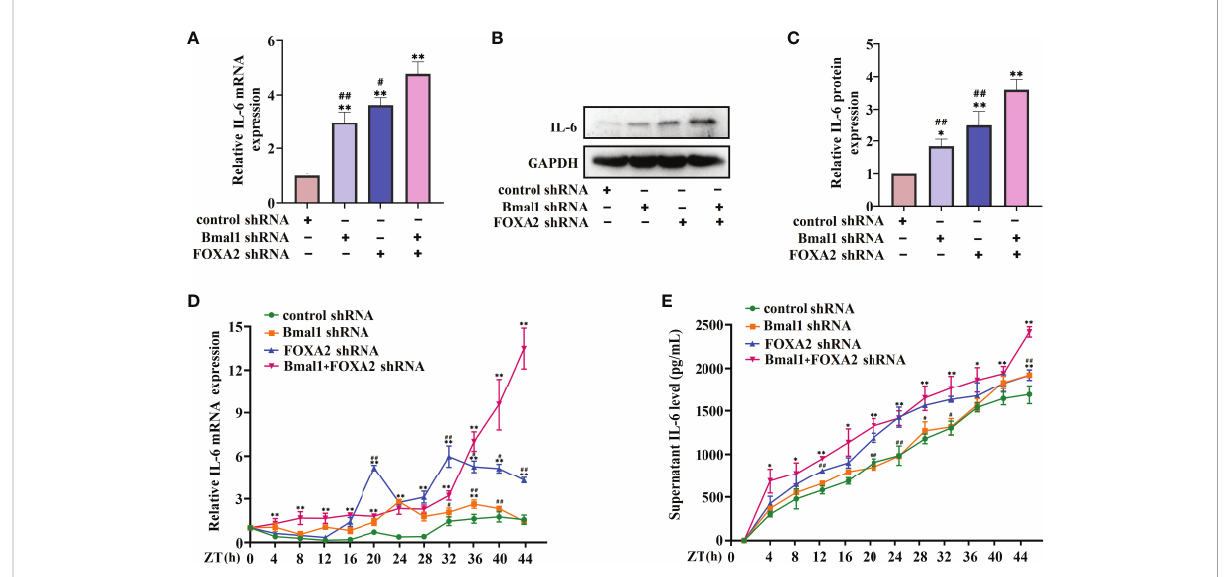
FIGURE 8 Double FOXA2 and BMAL1 stable depletion causes a signi fi cant increase of IL-6. The mRNA (A) and protein (B) levels of IL-6 in 16HBE cells transfected with control shRNA, FOXA2 shRNA, BMAL1 shRNA, and FOXA2+BMAL1 shRNA by RT-qPCR and Western blot, respectively. ImageJ software was used to quantify the IL-6 bands (C) . RT-qPCR (D) and ELISA (E) analysis of mRNA and secretion levels of IL-6 in 16HBE cells transfected with control shRNA, FOXA2 shRNA, BMAL1 shRNA, and FOXA2+BMAL1 shRNA cells in response to serum shock synchronisation. ZT, zeitgeber time. All data shown are representative data of one out of at least 3 independent experiments, * p < 0.05, ** p < 0.01 compared with control shRNA cells. # p < 0.05, ## p < 0.01 compared with FOXA2+BMAL1 shRNA cells. One-way ANOVA with Tukey ’ s multiple comparison analysis method, and independent samples t-tests.